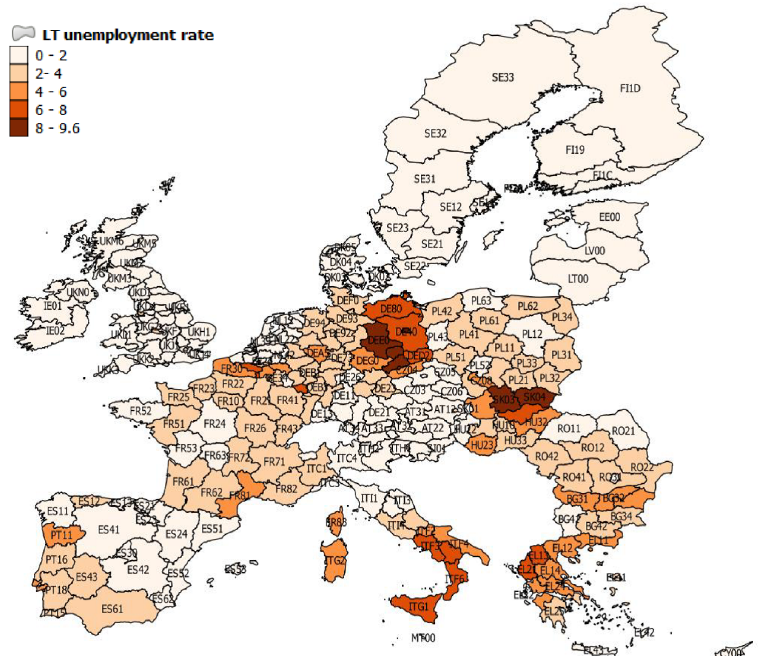
Figure 4: Long-term uneployment – 2008